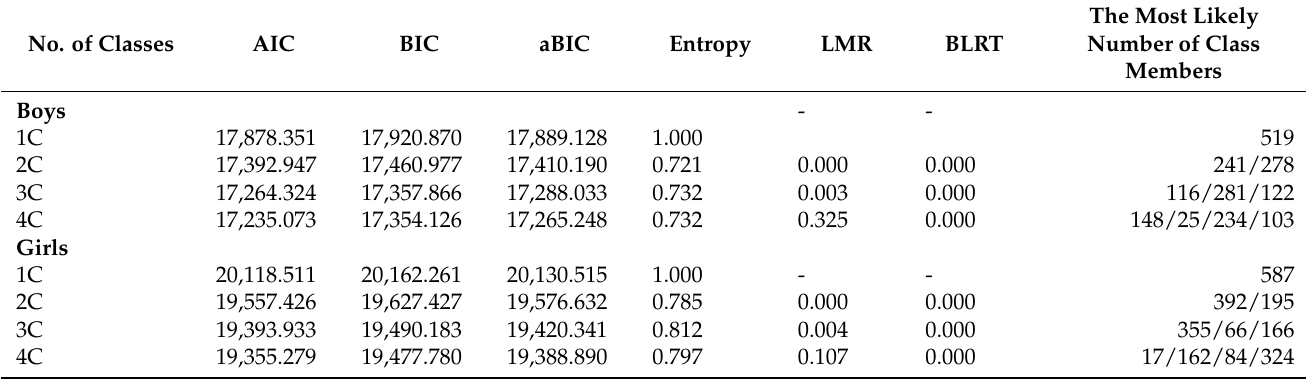
Table 3. Model comparison of latent profile analysis (personality